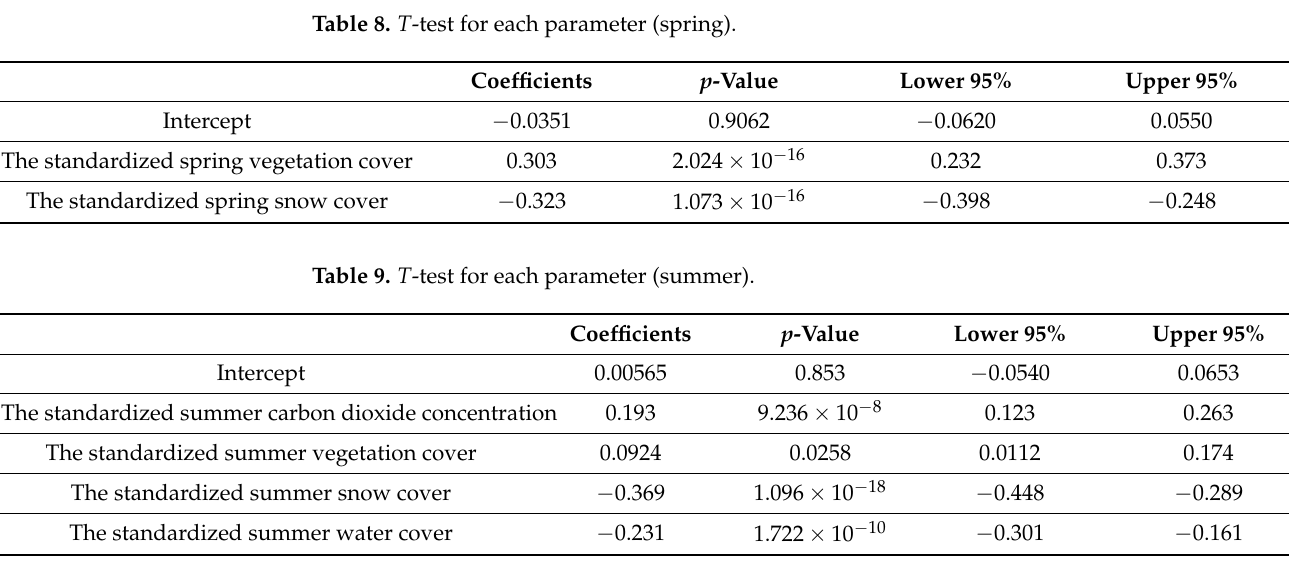
Table 8. T -test for each parameter (spring).